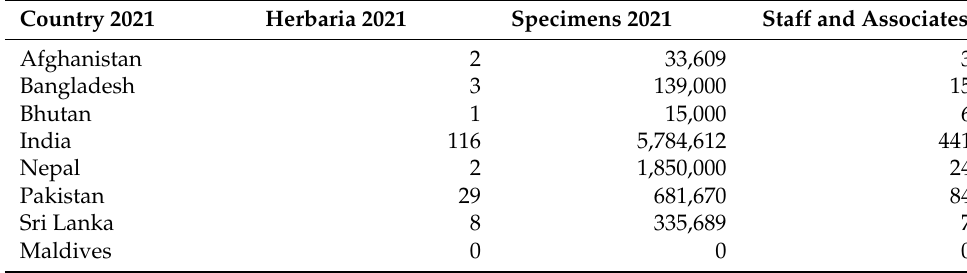
Table 1. Summary of the herbaria in each country of South